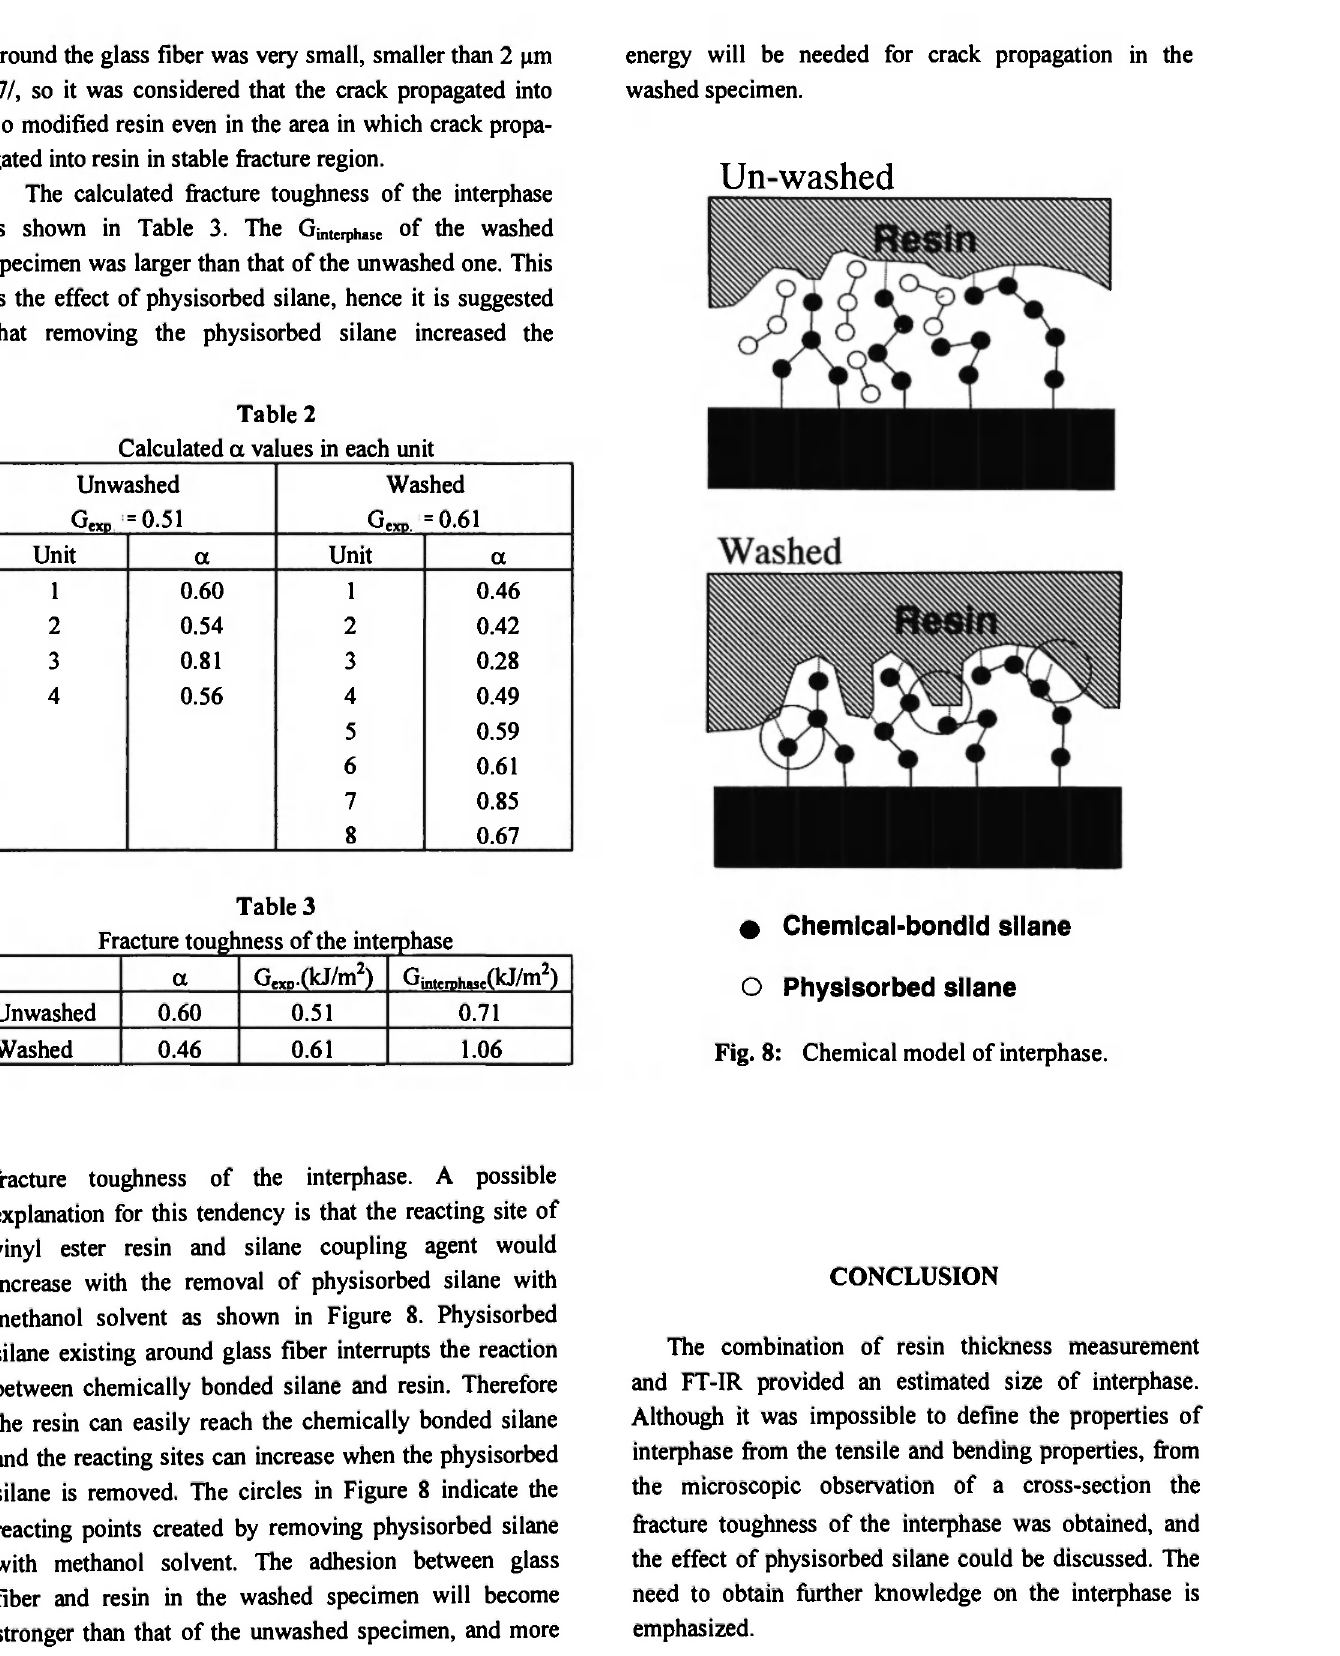
Fig. 8: Chemical model of interphase.